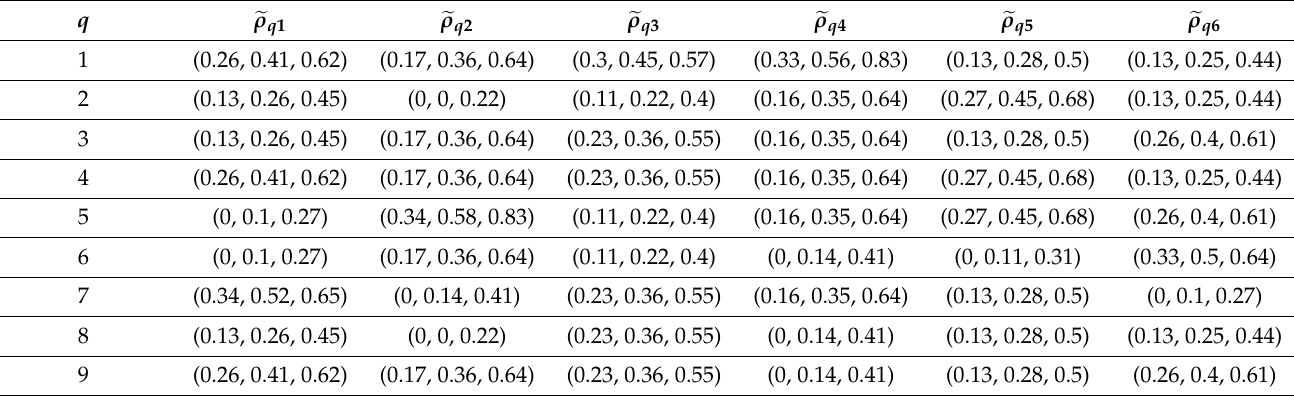
Table A1. Normalized performances of smart technology applications.